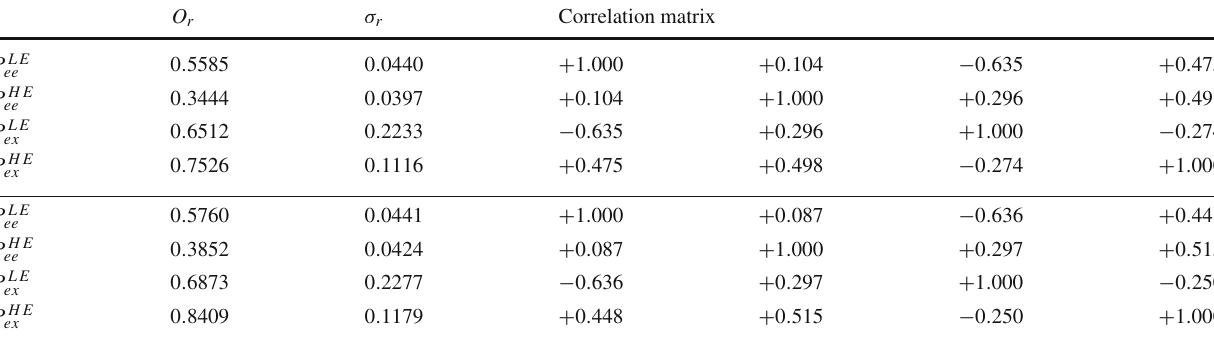
P ref ( E ) , where solid and dashed curves are identical. Dotted horizontal Fig. 1 Oscillationprobabilitiesasafunctionofneutrinoenergyfordif- = 0 . 25 , 0 . 3 , 0 . 35 (columns) and ferent values of the mixing angles s 2 linesindicatetheasymptoticvalues P LE and P HE .Thedatapointswith 12 = 0 , 0 . 1 (top and bottom rows, respectively), with P error bars show the observed values for the four probabilities, Eq. (2.2) s 2 ee ( P ex ) shown 14 as reported in Table 1 for the GS98 solar model (same in all panels). in red (blue). Solid curves correspond to the exact numerical proba- For definiteness we assume the 8 B solar neutrino flux to average over bilities, whereas dashed curves show our parameterization, Eq. (2.9). the production region and we show day-time probabilities The middle panel in the top row corresponds to our reference point, Table 1 Best fit value for the observations O r , their 1 σ uncertainties σ r , and correlation matrix ρ of the four observables. The upper (lower) part of the table corresponds to the GS98 (AGSS09) solar model